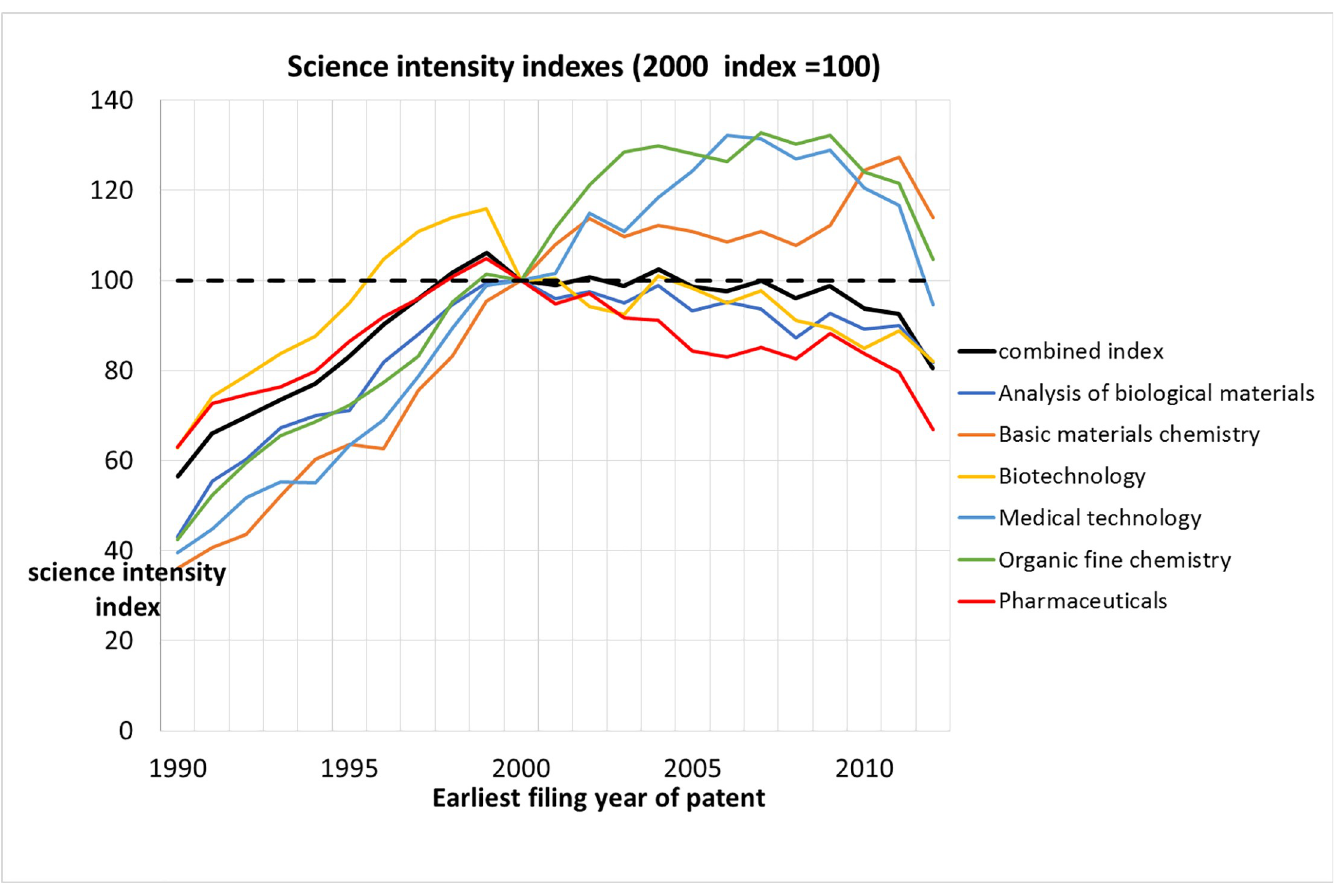
Fig 18. Trend of the composite indicator for six technological fields that are the most important for medical SB-SNPRs. The indicator value in the year 2000 is taken as a reference value (index = 100) for each field.